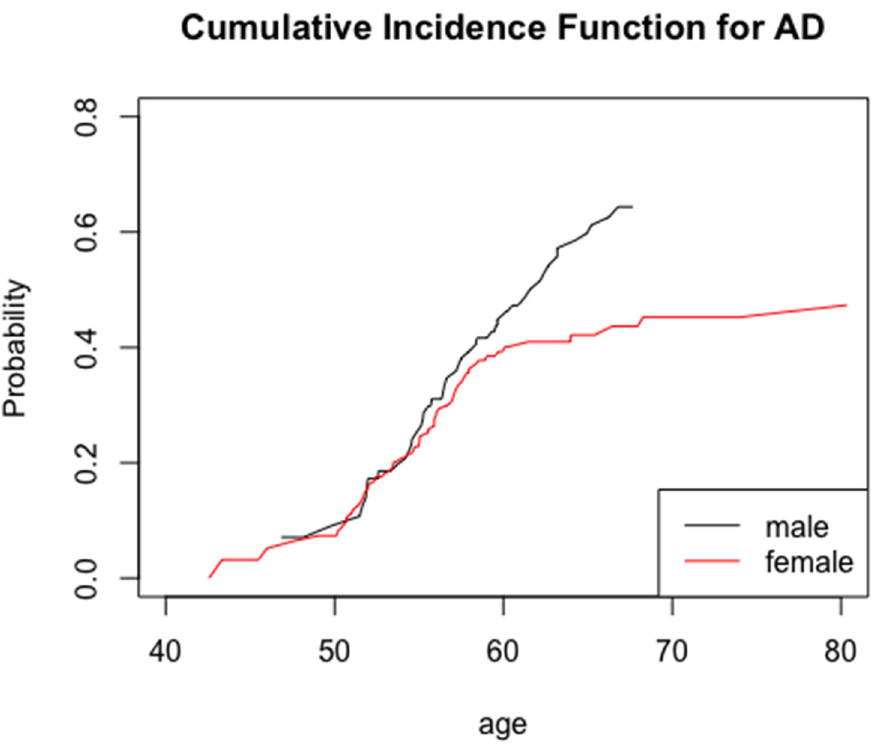
Figure 1. Non-parametric cumulative incidence function for AD separated by sex with left truncation and right censoring. Table 2. Hazard ratio for AD dementia by sex in adults with Down